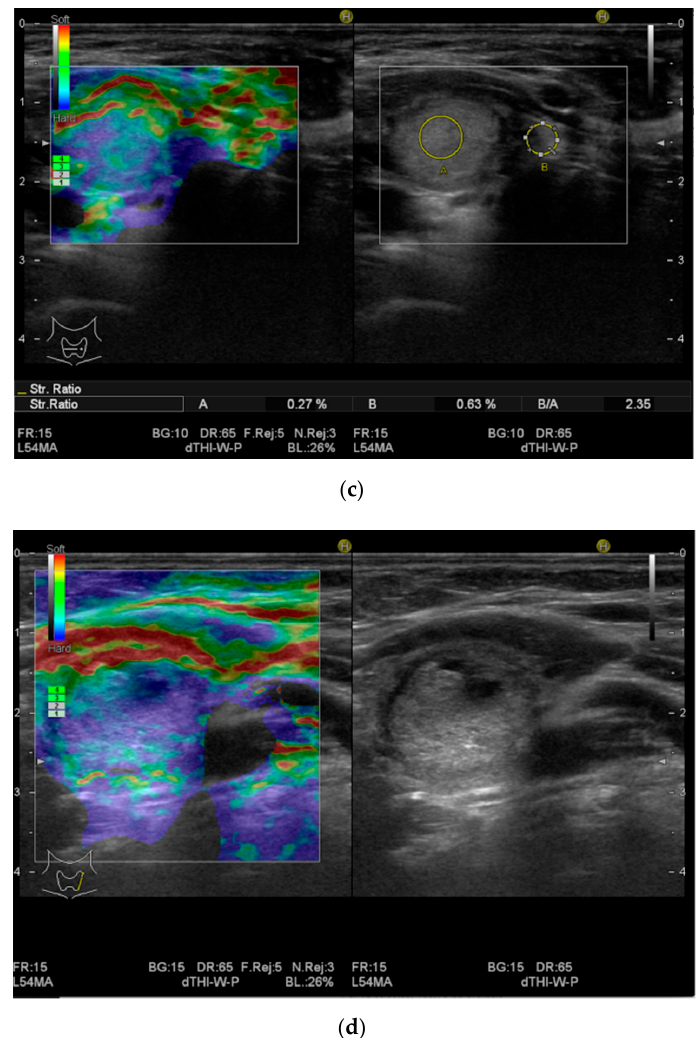
Figure 1. Observer categories of qualitative strain elastography (SE). ( a ) Very low stiffness, color score 1, completely soft; ( b ) Low stiffness, color score 2, predominantly soft; ( c ) Intermediate stiffness, color score 3, central hard core; ( d ) Increased stiffness, color score 4, completely hard. Volumetric Doppler examination displays a three-dimensional image of the scanned area, placing the lesion in the middle of the region of interest (ROI), after a rotational 180° scan inside the probe. A thorough evaluation of the nodule’s vascularization is completed by the display of spreading vessels from the neighboring parenchyma into the lesion. Figure 2 shows the possible 3D Doppler pattern that we observed.